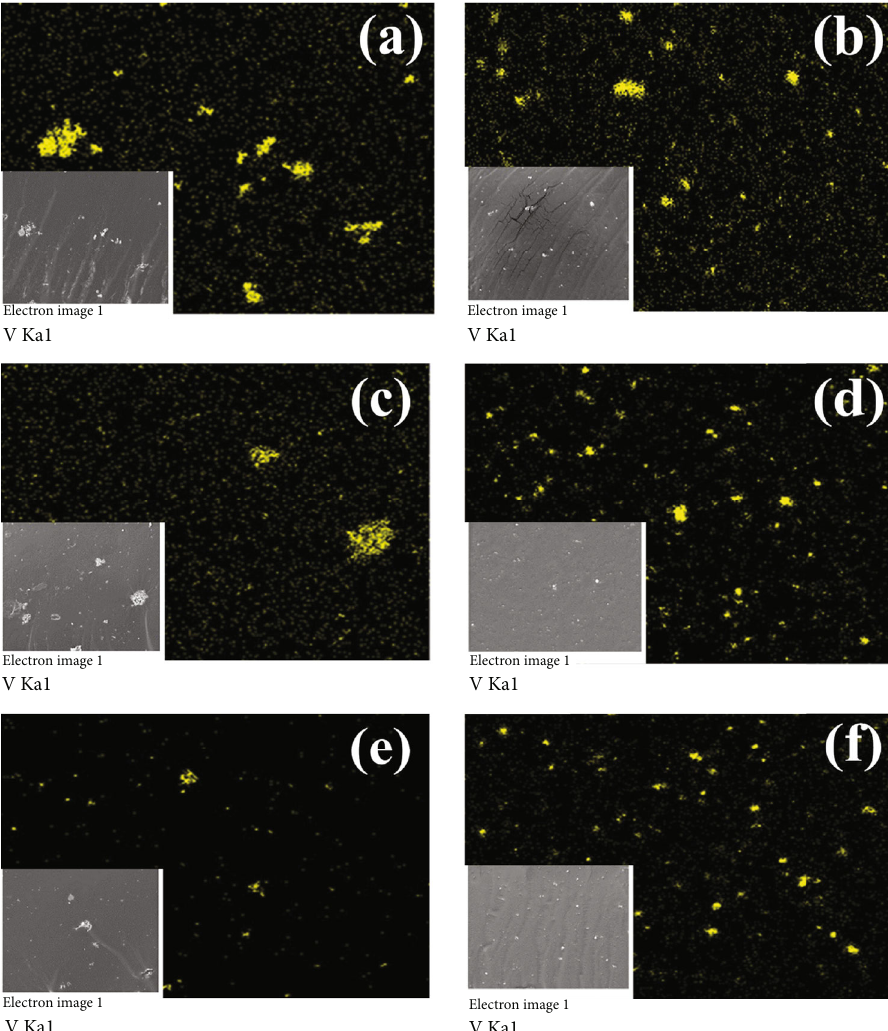
Figure 11: Electron images and EDX dot maps of polymer fi lms containing di ff erent types and concentrations of VO VO (1.0 wt%), (b) acrylic/VO (1.5 wt%), (c) acrylic/VO 2 2 @PSS:PEDOT-24 (1.0wt%), and (f) acrylic/VO (e) acrylic/VO 2